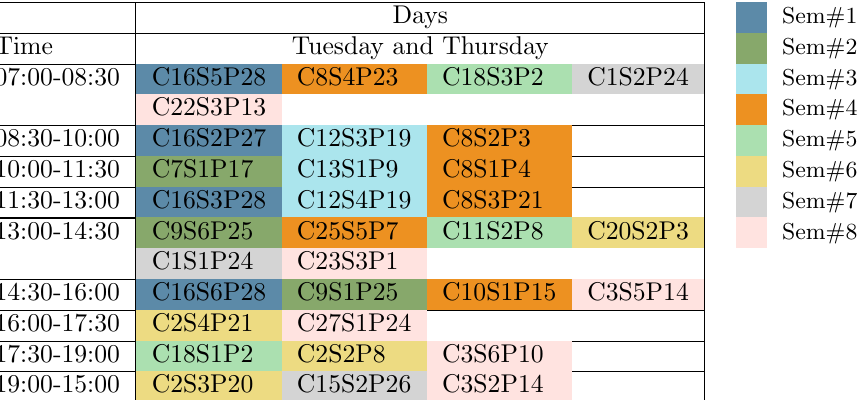
Figure 4. Timetable of second strategy for courses in day scheme A: Monday, Wednesday and Friday, three classes of 1 h per week.